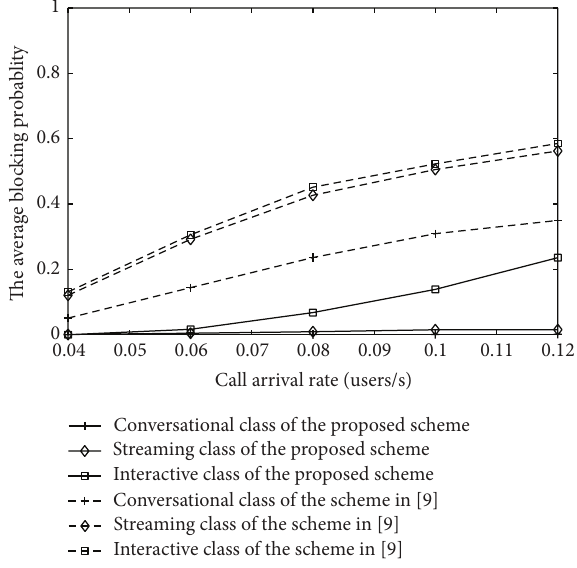
Figure 12: The blocking probability of IDMA system.